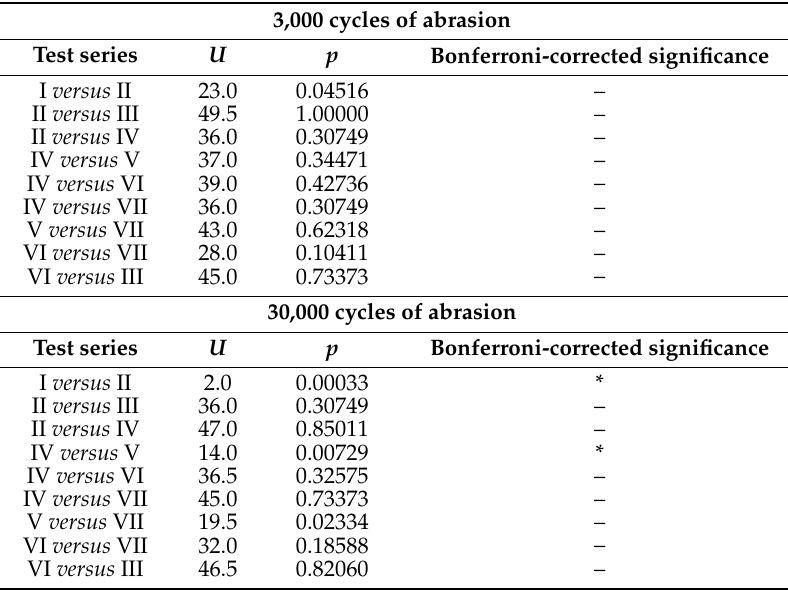
Table 4. Statistical analysis ( U -Test, p = 0.05 with Bonferroni correction, p = 0.0125) of test series with respect to remaining chitosan coating on